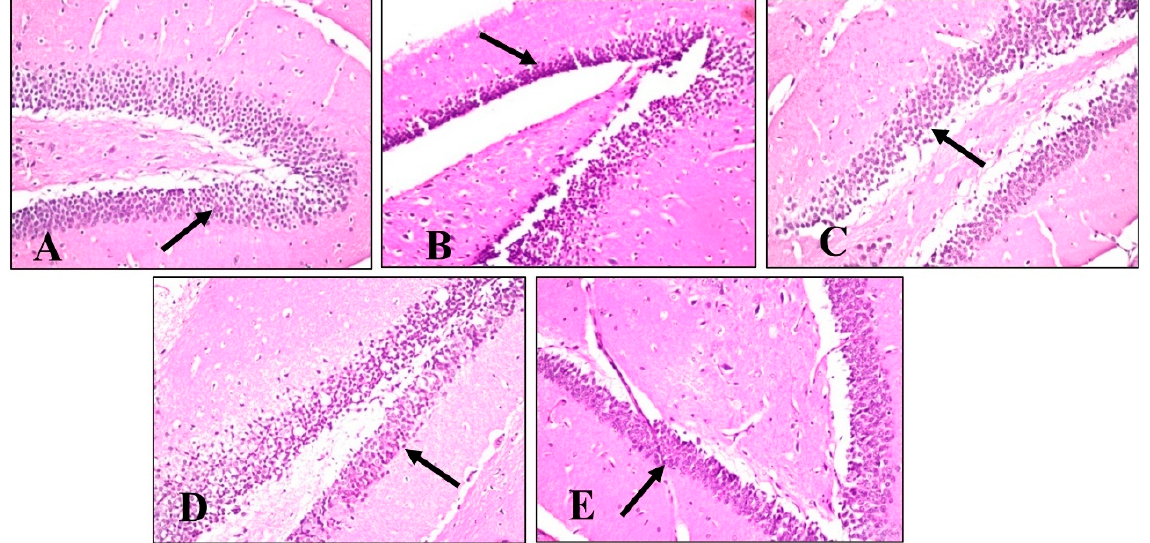
Figure 8. Histopathology of mice brain (Fascia dentata and hilus in hippocampus sections) with H&E × 40. ( A ) Normal control group showing normal histological findings (Black arrow-normal neuron). ( B ) LPS-administered mice group showing nuclear pyknosis and degeneration in most of the neurons (Black arrow). ( C ) BME-administered mice group showing normal histological findings (Black arrow-normal neuron). ( D ) BDMF-administered mice group showing normal histological findings (Black arrow-normal neuron). ( E ) BBF-administered mice group showing normal histological findings (Black arrow-normal neuron). BME: B. armeniaca methanolic extract; BDMF: B. armeniaca dichloromethane fraction; BBF: B. armeniaca butanol fraction; LPS: lipopolysaccharide.